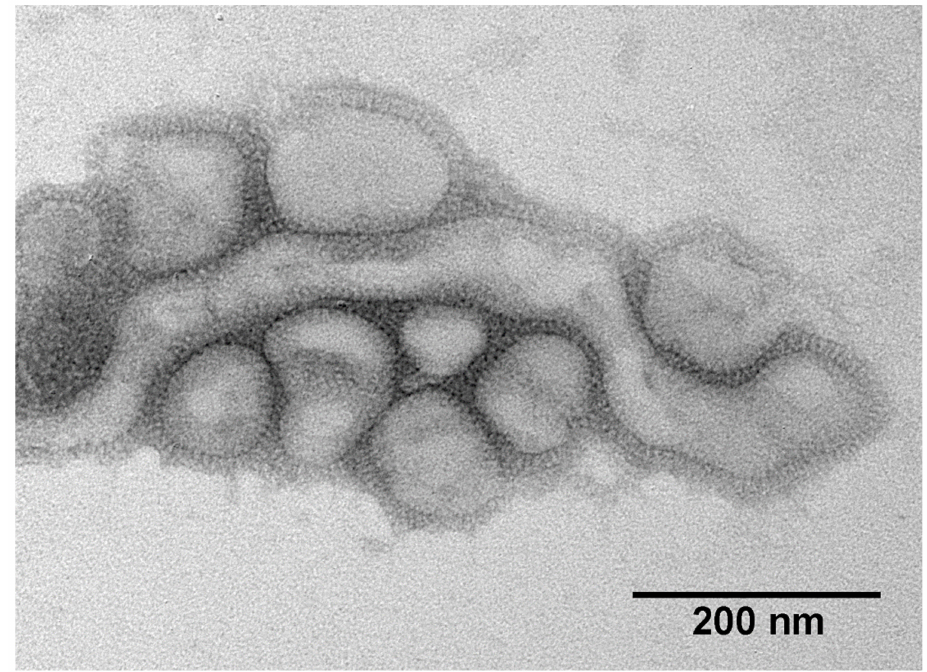
Figure 1. Electron micrograph of IAV particles. Virions consist of envelope, M1, and core. The viral envelope is a lipid bilayer contain- ing three membrane proteins: HA, NA, and the proton channel M2 [27] (Figure 2).